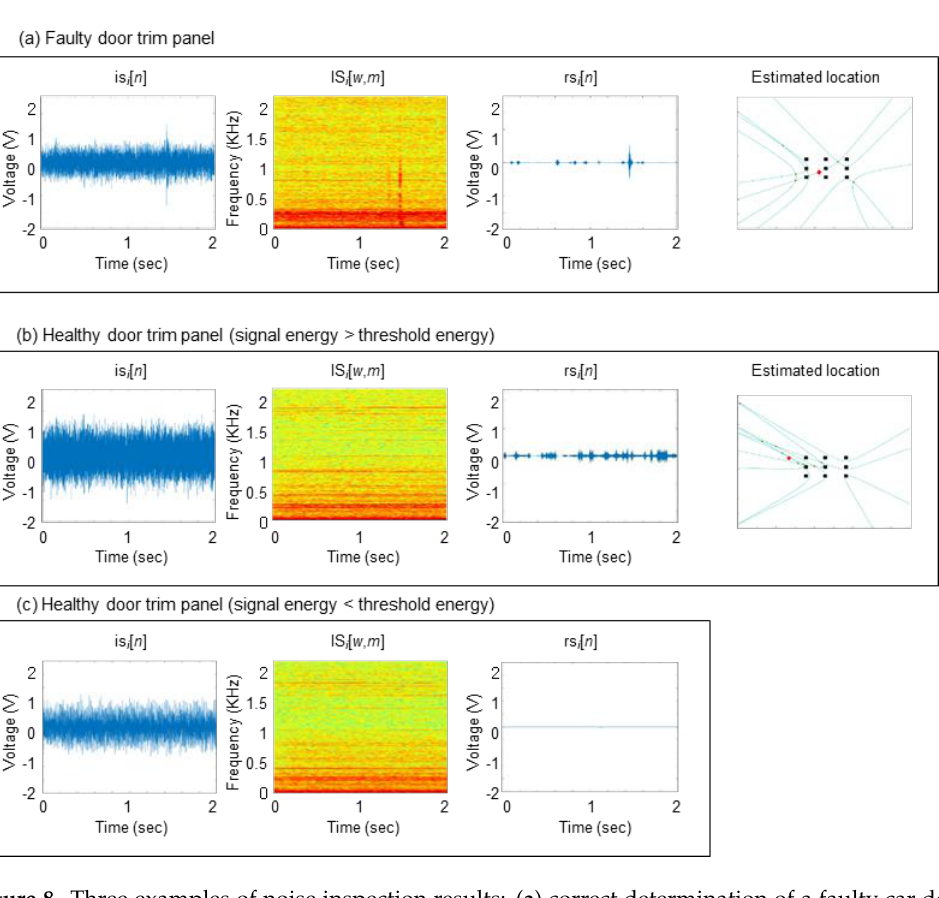
Table 2. The experimental results of the 200 inspections (conventional method).